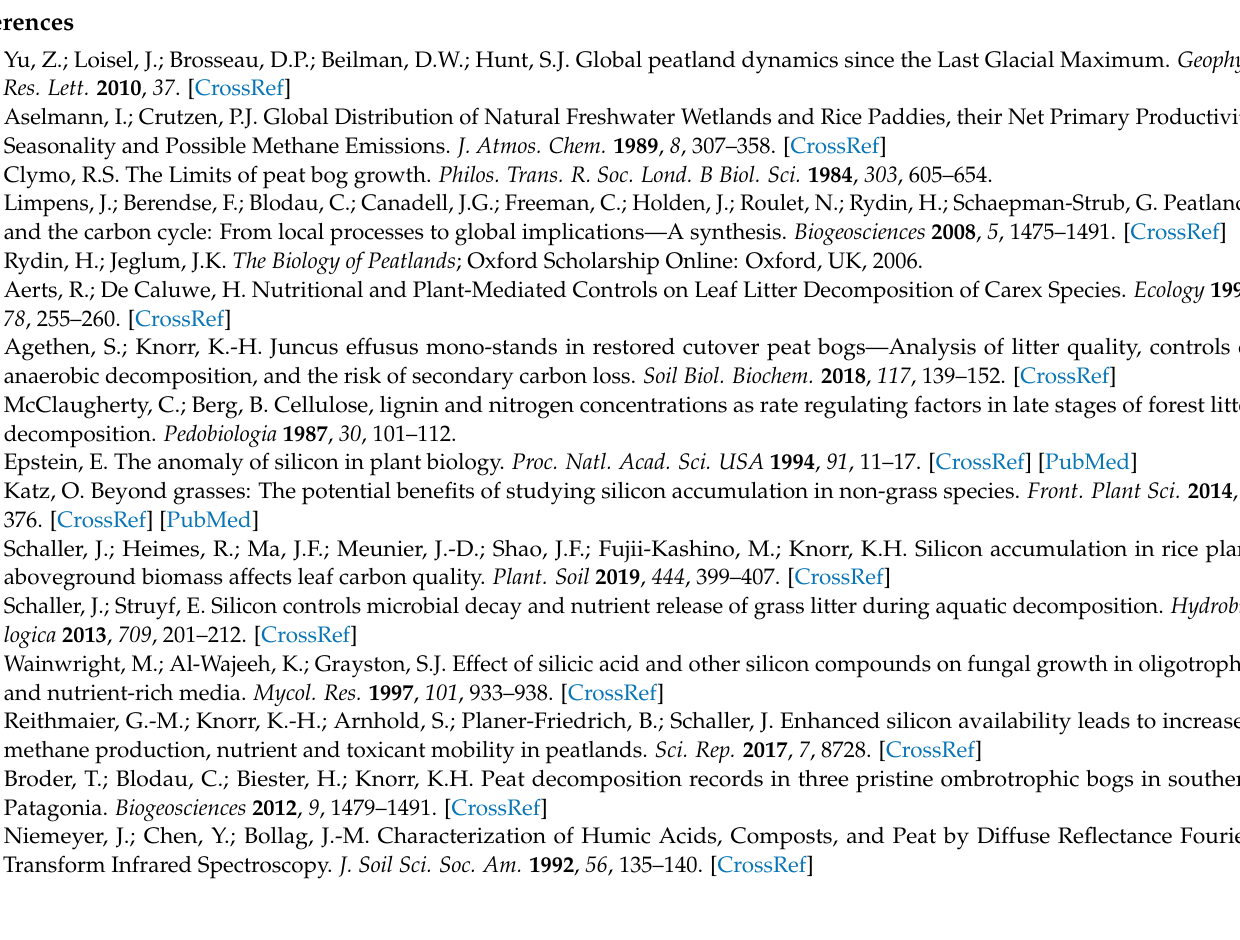
Figure A3. FTIR Spectra of Carex roots before the incubation. Low P fertilized plants are shown in blue, high P fertilized plants are shown in